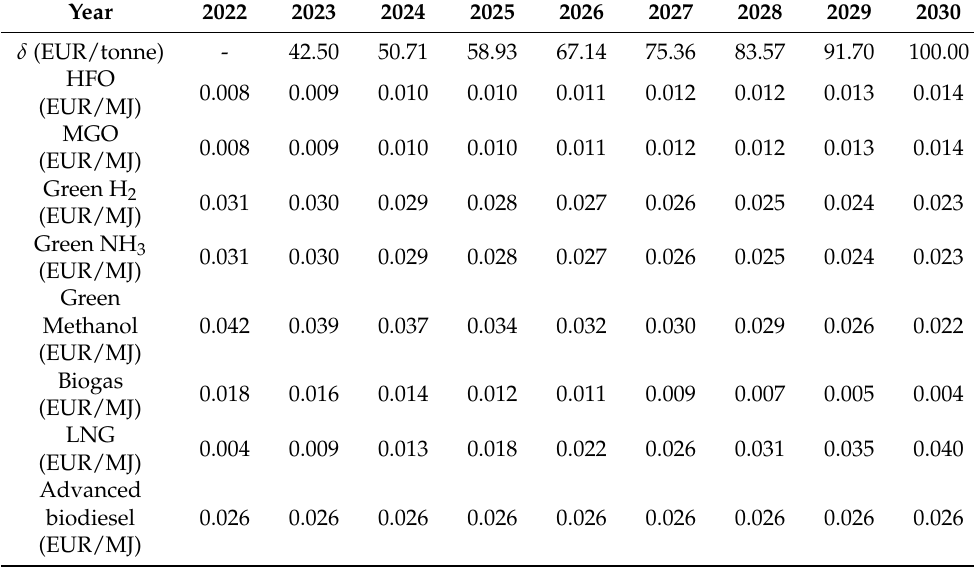
Table 6. CO 2 penalty and fuel cost scenarios with projections up to 2030 (and beyond) as per the proposed Fit for 55 legislation package. A linear distribution has been used on a per year basis. In this work, values of EUR/metric quantity have been obtained from the available literature and converted to EUR/MJ. Where projections were needed, and unavailable linear relationships were assumed. Fuel costs were obtained from the following references [31,34–37]. For biodiesel the cost fluctuates based on location and feedstock end price, but was assumed to be as reported in [37] with a constant price up to